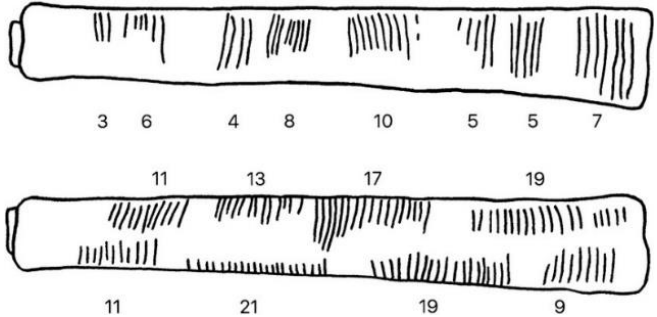
Figure 4. The tally stick with Ishango bone and related numbers [18].